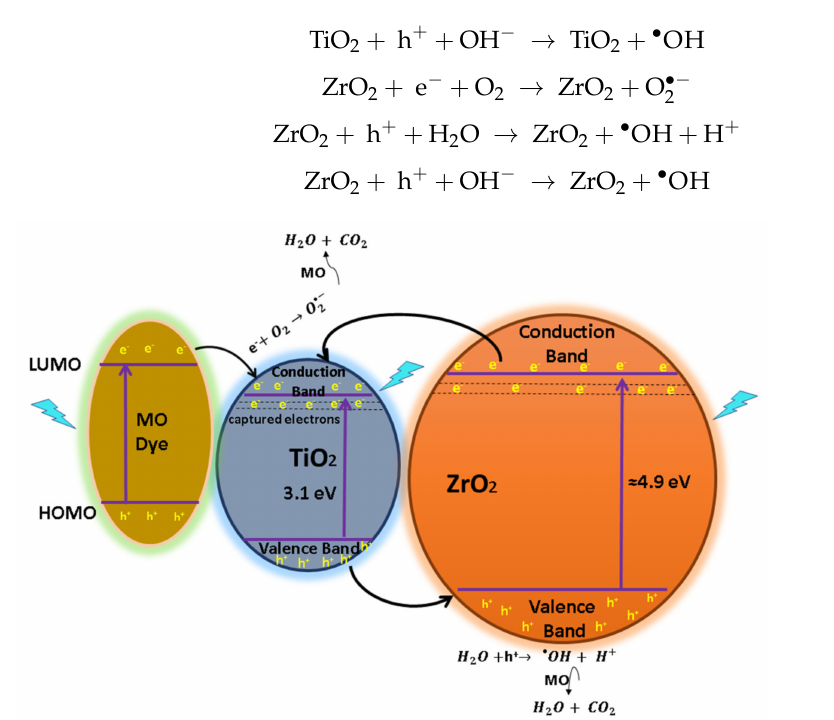
Figure 13. Diagram of e − /h + pair separation and the possible reaction mechanism for the TZ-1 photocatalysts under UV irradiation with dye